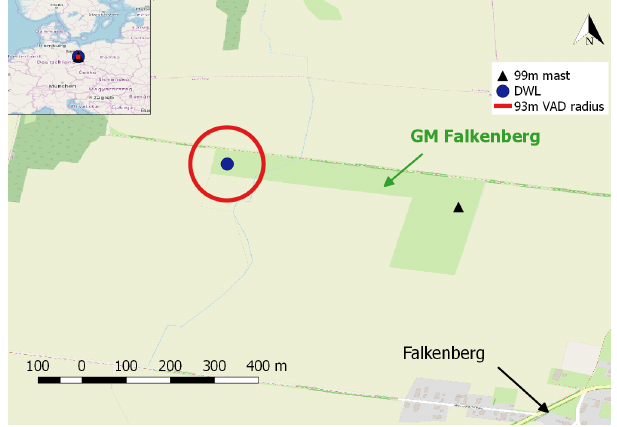
Figure 1. Sketch of the measurement site at MOL-RAO, GM Falkenberg. Map data © OpenStreetMap contributors 2019. Dis- tributed under a Creative Commons BY-SA